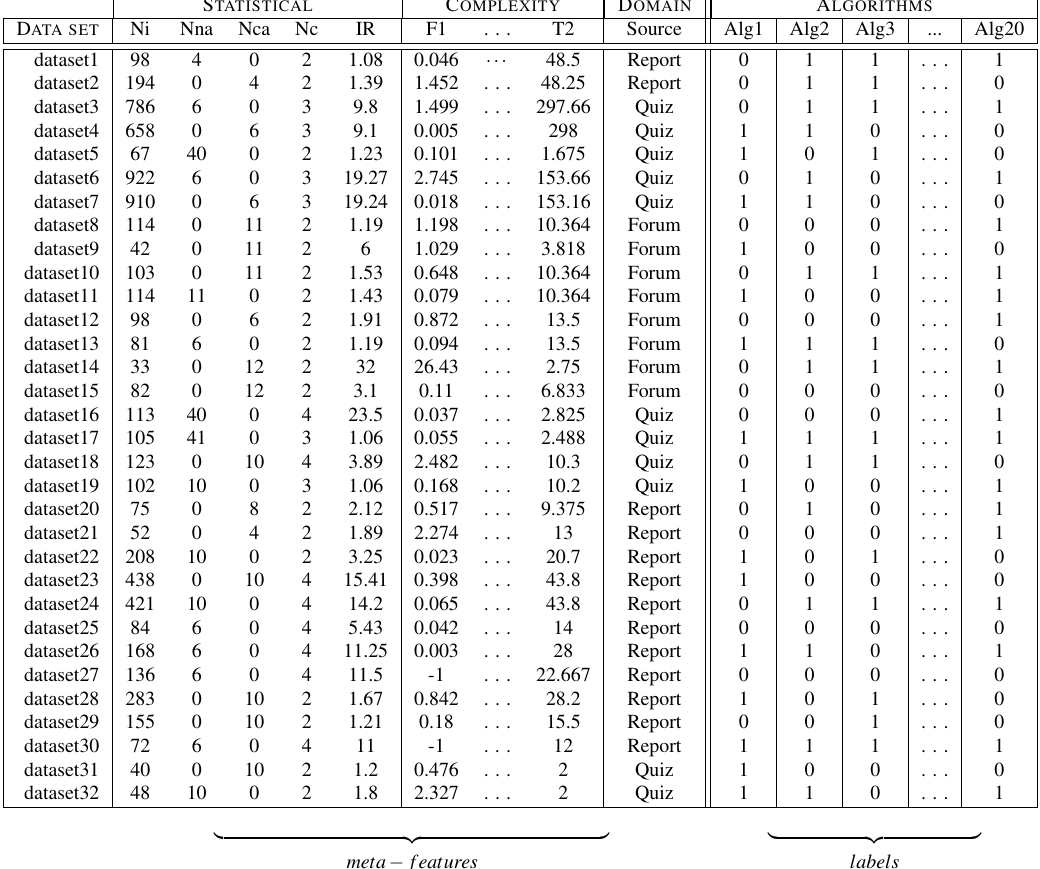
Table 4: Multi-label meta-data set. The left side corresponds to statistical, complexity and domain features of single-label Moodle data sets for predicting students’ performance. The right side corresponds to the classes, having one label per algorithm considered.